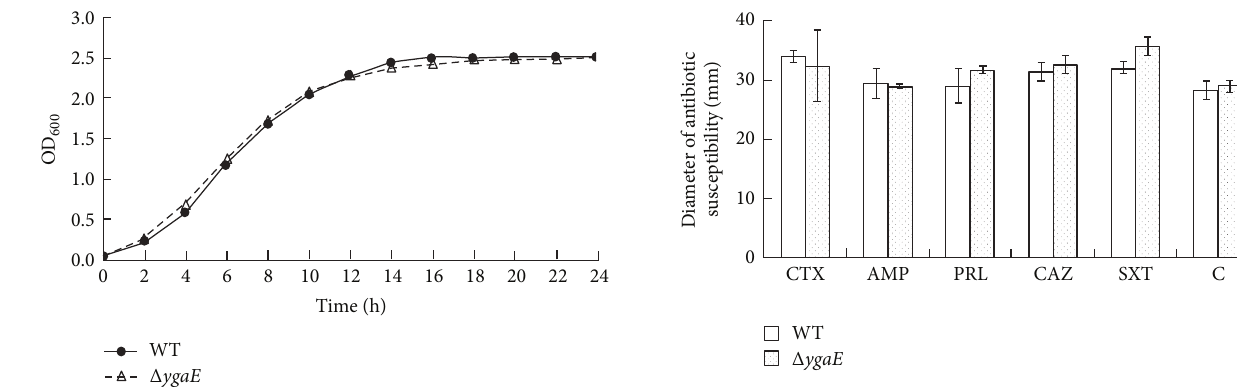
Figure 3: Growth of wild type (WT) and Δ ygaE in LB broth under hyperosmotic stress was monitored at OD 600 . Each datapoint represents the mean of three independent measurements.